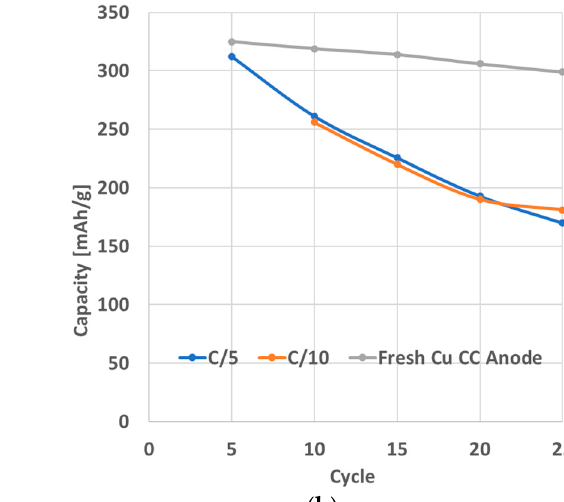
Figure 13. The capacity retention of ( a ) cathode half-cells over 50 cycles and ( b ) anode half-cells over 25 cycles compared to cathodes and anodes made from fresh Al and Cu CC.